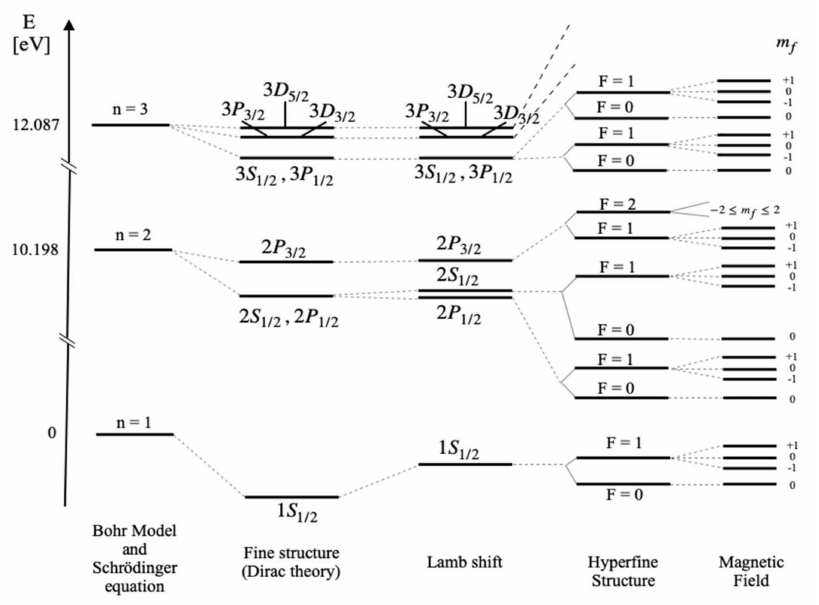
Figure 6. The energy levels of the Hydrogen atom are now being studied for the case of the analogous antimatter